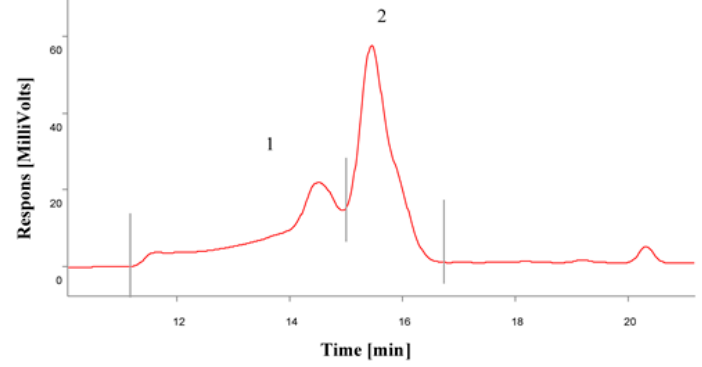
Figure 2. Gel permeation chromatography (GPC) gel chromatogram for fractions 1 (C 17 H 33 COO(CH 2 CH 2 O) n OCC 17 H 33 ) and 2 (C 17 H 33 COO(CH 2 CH 2 O) n CH 3 ).